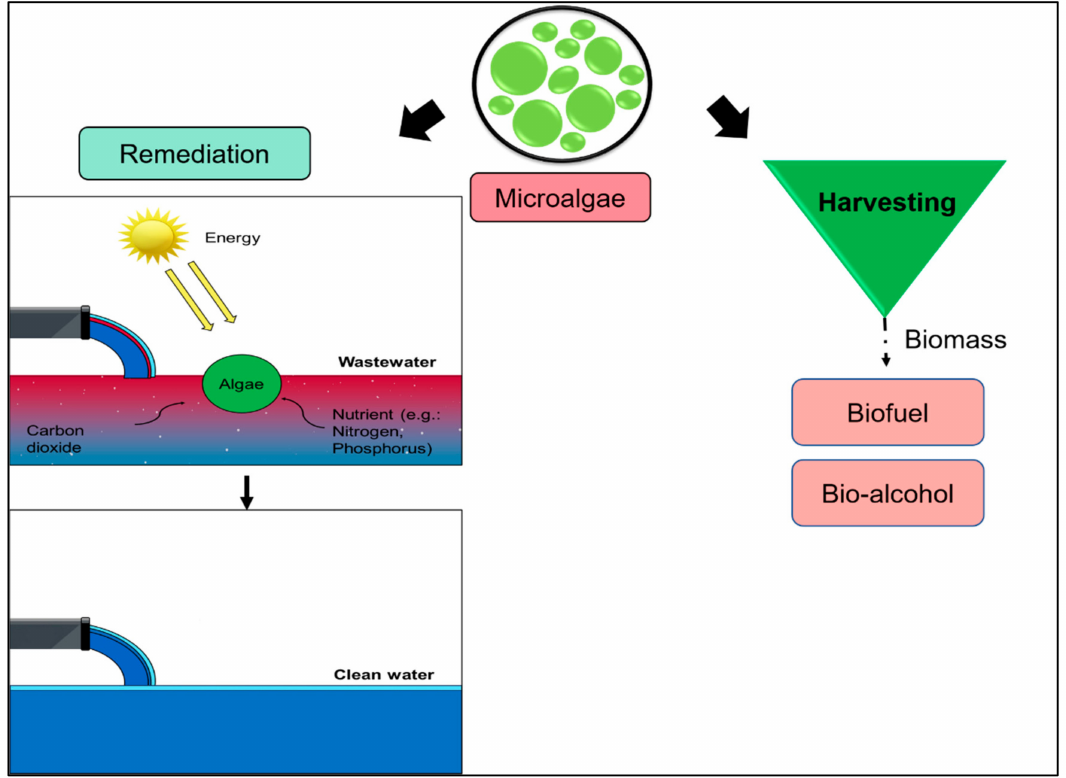
Figure 17. Cultivation of microalgae in treating